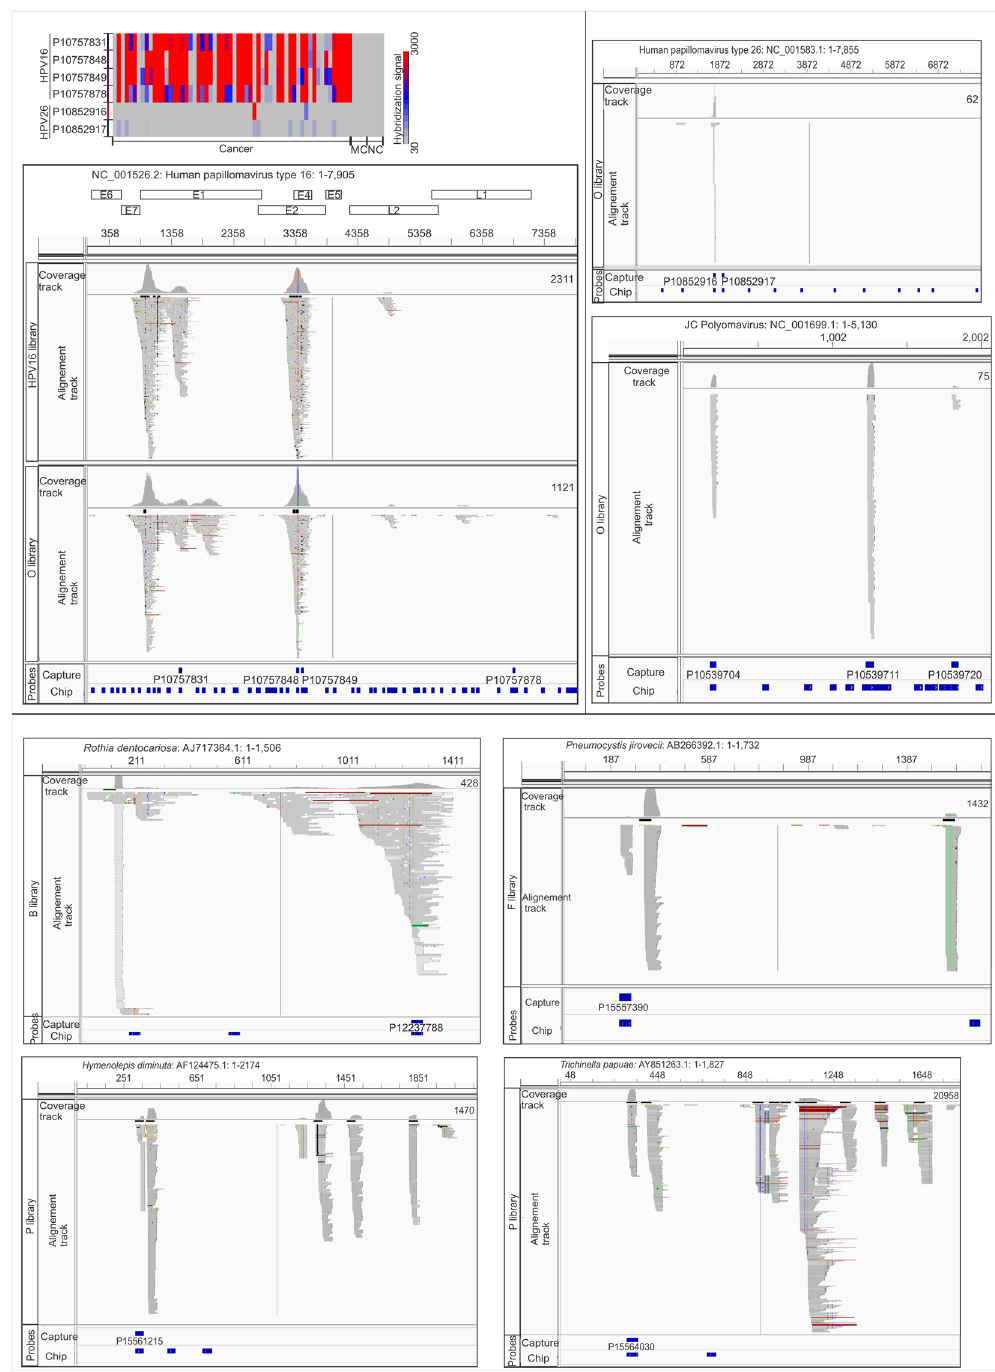
Figure 5. Probe capture sequencing alignment is shown for individual capture pools (HPV16, O, B, F and P). HPV16 capture probe comprised of set of HPV16 specific probes, O capture probes consisted of certain viral and bacterial probes, B pool comprised of bacterial probes, F consisted of fungal probes and P comprised of parasitic probes that are mentioned in Table S3. The hybridization signals of the HPV probes used for the capture are shown as heat map in the figure. Six pools of whole genome and transcriptome amplified DNA plus cDNA was hybridized to a set of biotinylated conserved and specific viral probes, then captured on streptavidin beads, and used for tagmentation library preparation and deep sequencing with paired –end 250-nt reads. The miseq reads from individual capture when aligned with the metagenome of PathoChip (Chip probes) was found to cluster mostly at the capture probe regions. The genomic location along with the number of miSeq reads are mentioned in the figure for each